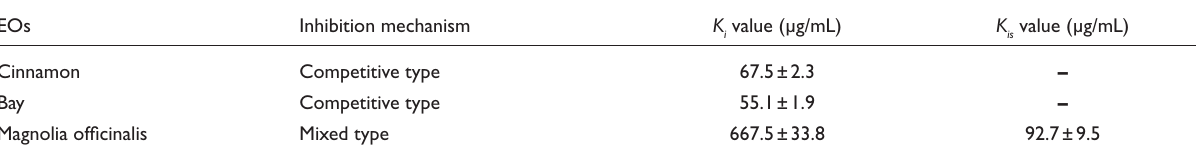
and K values of cinnamon, bay, and magnolia officinalis i is